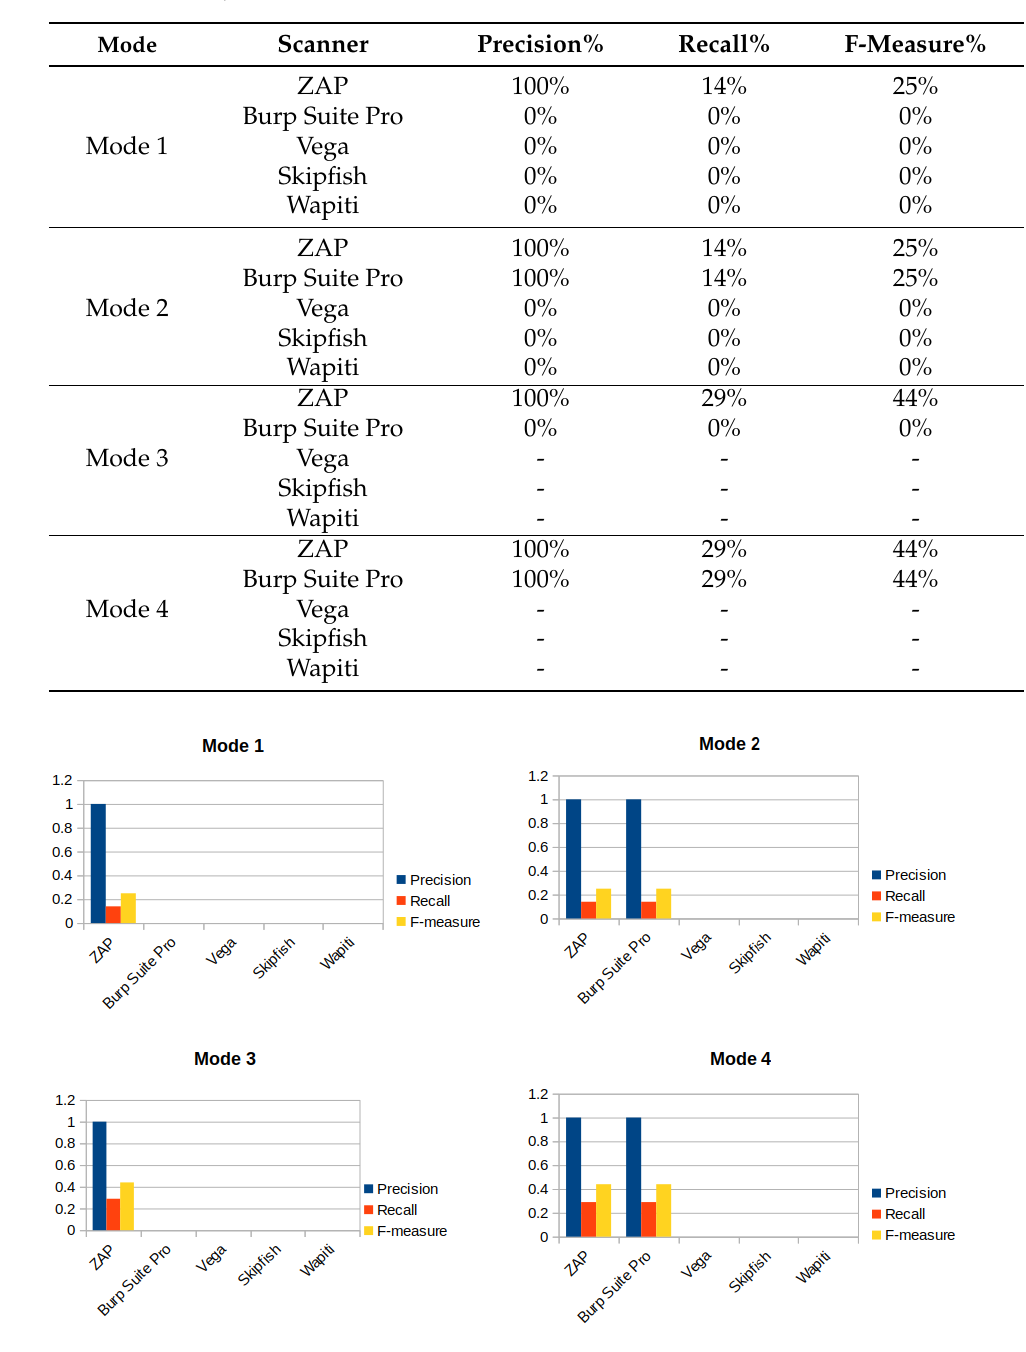
Table 9. Precision, recall and F-measure values for all scanners.